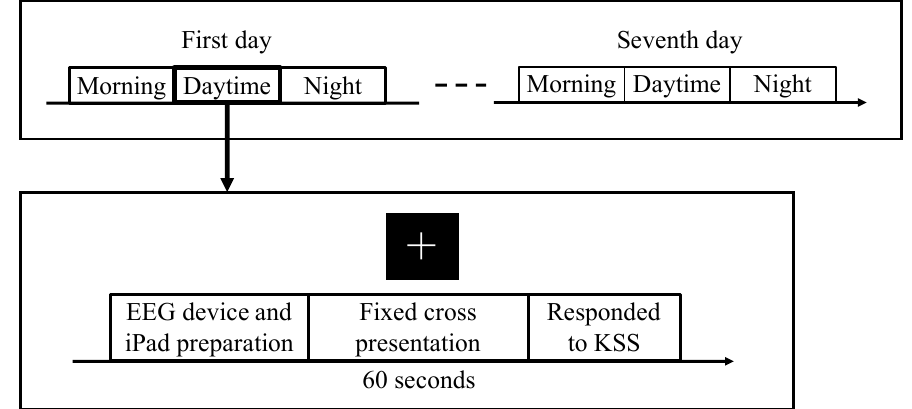
Figure 2. The experimental procedure, which participants repeated for 7 days. EEG recordings were obtained three times a day. A fixed cross was presented during